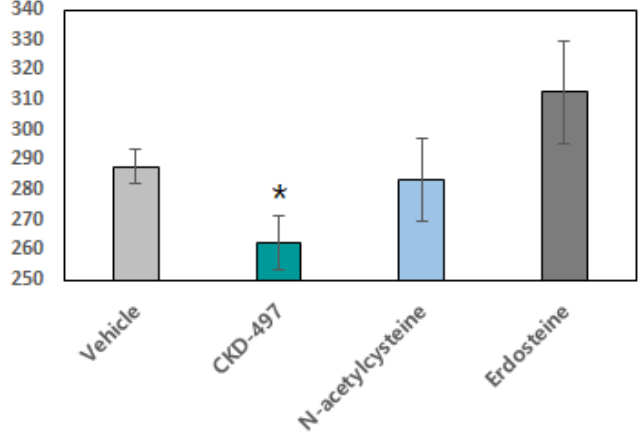
Figure 4. CKD-497 reduced viscosity. CKD-497 and two positive control ( N -acetylcysteine, erdosteine) were added in 15% of mucin solution and then stirred at 37 °C for 1 h. N -acetylcysteine and erdosteine viscosity was detected by microrheometer. All experiments were repeated three times and data are expressed as the mean ± SEM ( n = 3). * p < 0.05 compared with vehicle.